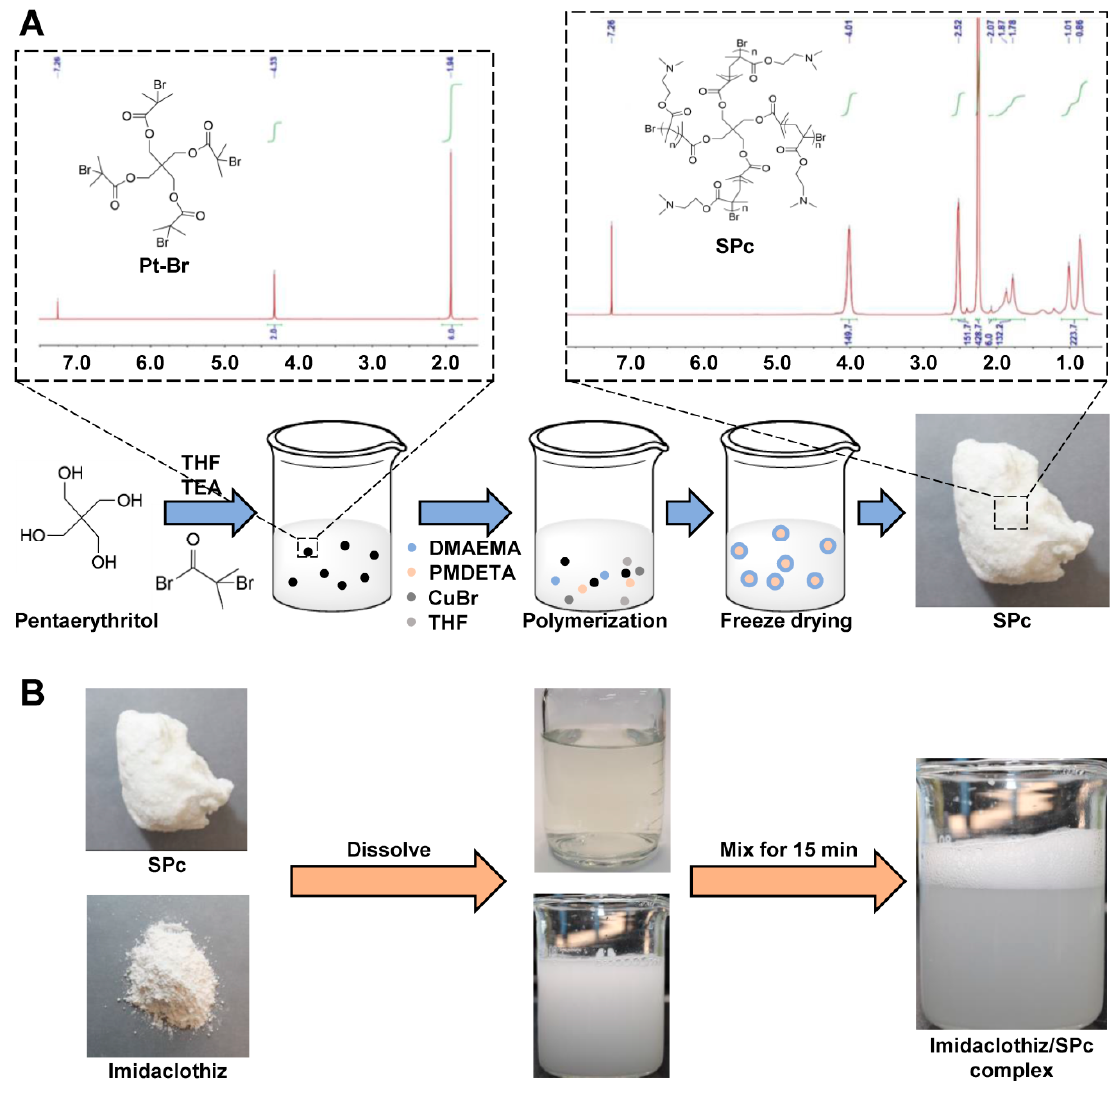
Figure 8. Synthesis route of SPc ( A ) and preparation of imidaclothiz/SPc complex ( B ).